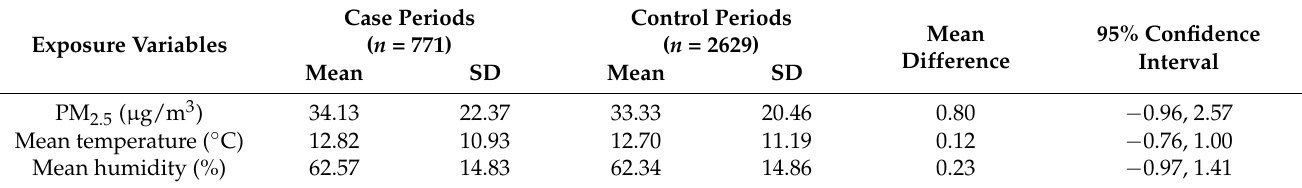
Table 2. Summary statistics for daily exposure variables during the study period of 2006–2016.